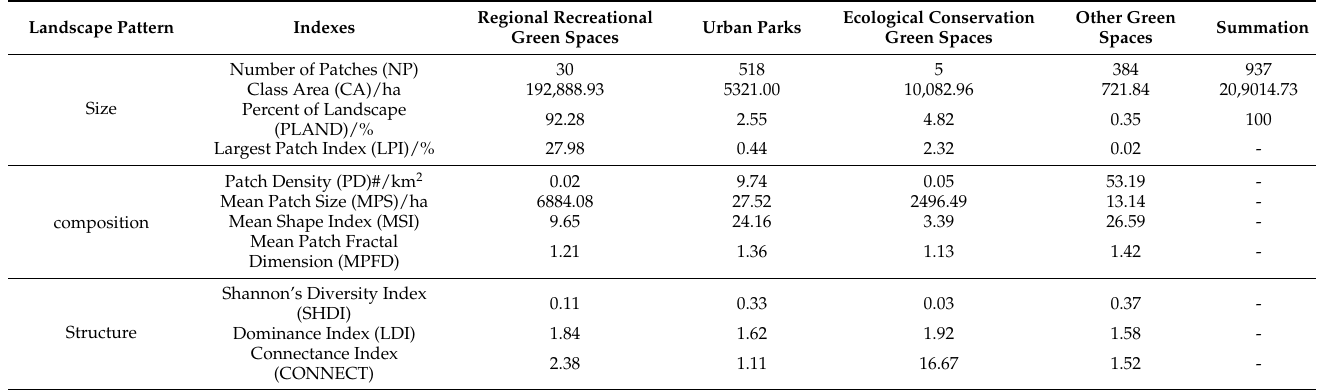
Table 3. Evaluation results of current